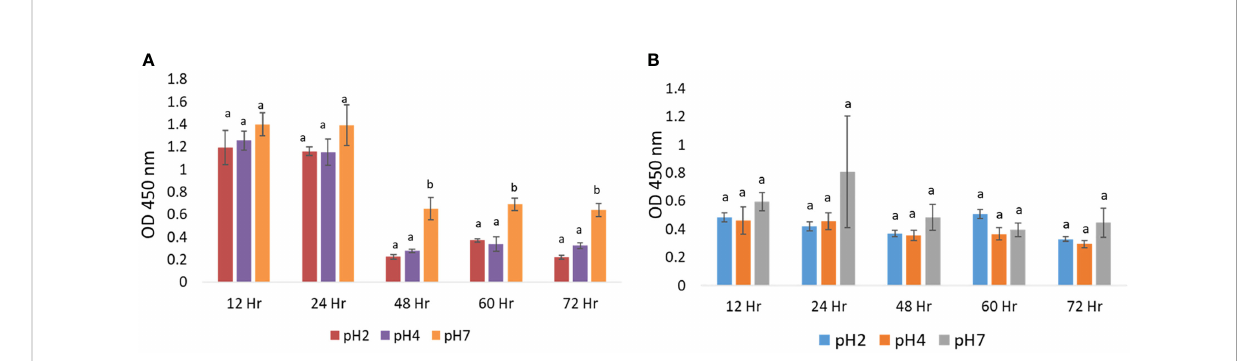
FIGURE 1 Relative cellular activation in microenvironments at pH 2, 4, and 7: (A) CCK-8 assay analysis of the effect of pH 2, 4, and 7 culture media on J774A.1 macrophage cell survival; (B) WST-1 assay analysis of the effect of pH 2, 4, and 7 culture media on J774A.1 macrophage cell survival. The a, b means with a signi fi cant difference through the Scheffe and one-way ANOVA